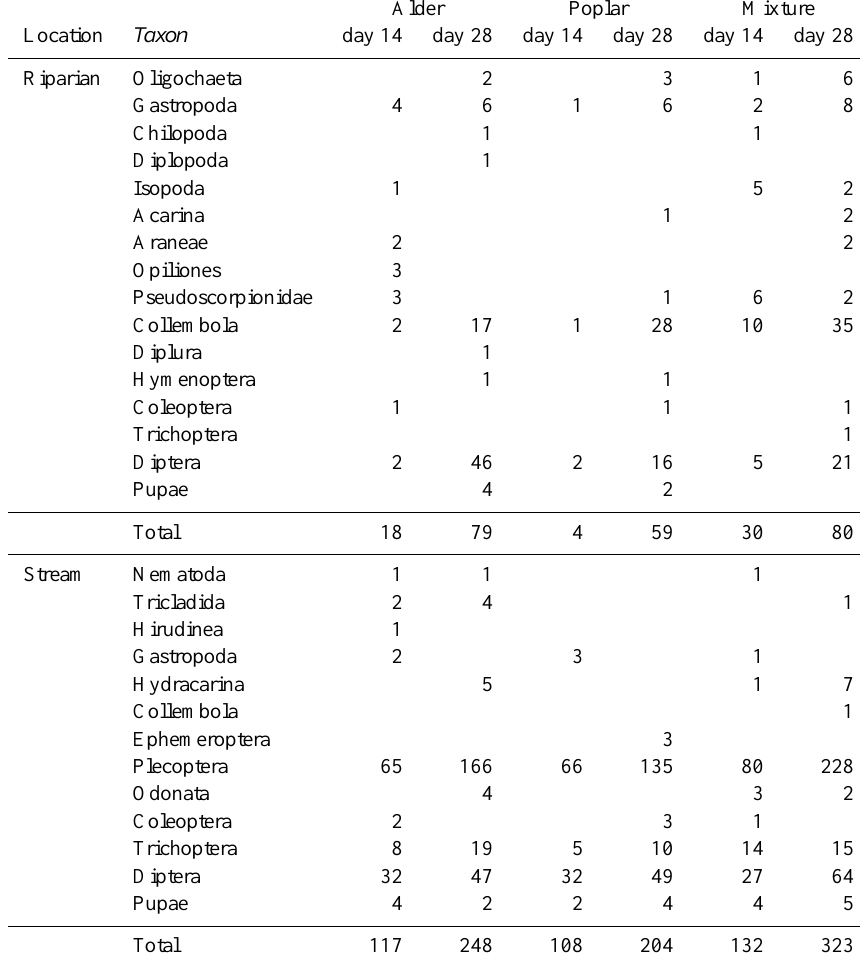
Table 2. Total abundance (sum of three bags) of taxonomic groups associated with leaves of alder, poplar and mixture decomposing in the stream and at the riparian zone of Ribeira do Botão after 14 and 28 days. Taxa assigned to the group of the detritivores were the Isopoda, Collembola, Diplura, Leuctridae (Plecoptera), Lepidostomatidae and Sericostomatidae (Trichoptera) and Tipulidae